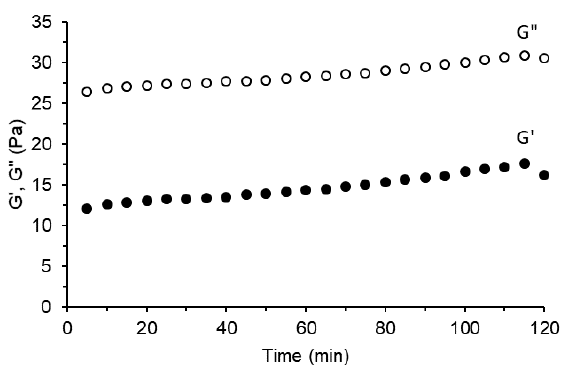
Figure 5. Mechanical spectra of the sample containing 15 wt% starch and propylene glycol-to-DMSO mass ratio of 50:50.